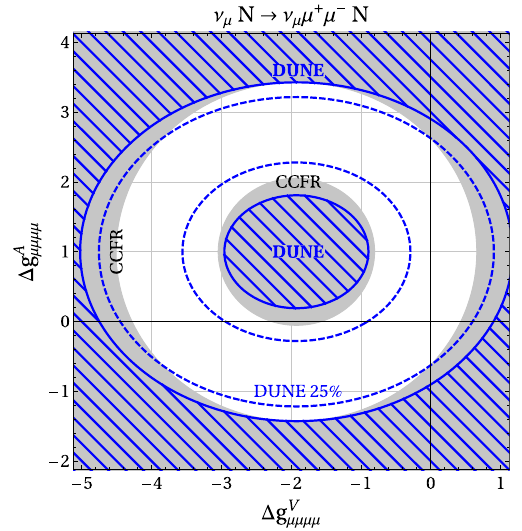
Fig. 16 95% CL sensitivity of a 40% (blue hashed regions) and a 25% (dashed contours) uncertainty measurement of the ν μ N → ν μ μ + μ − N cross section at the DUNE near detector to modifications of the vec- tor and axial-vector couplings of muon-neutrinos to muons. The gray regions are excluded at 95% CL by existing measurements of the cross section by the CCFR Collaboration. The intersection of the thin black lines indicates the SM point. A 40% precision measurement could be possible with 6 years of data taking in neutrino mode